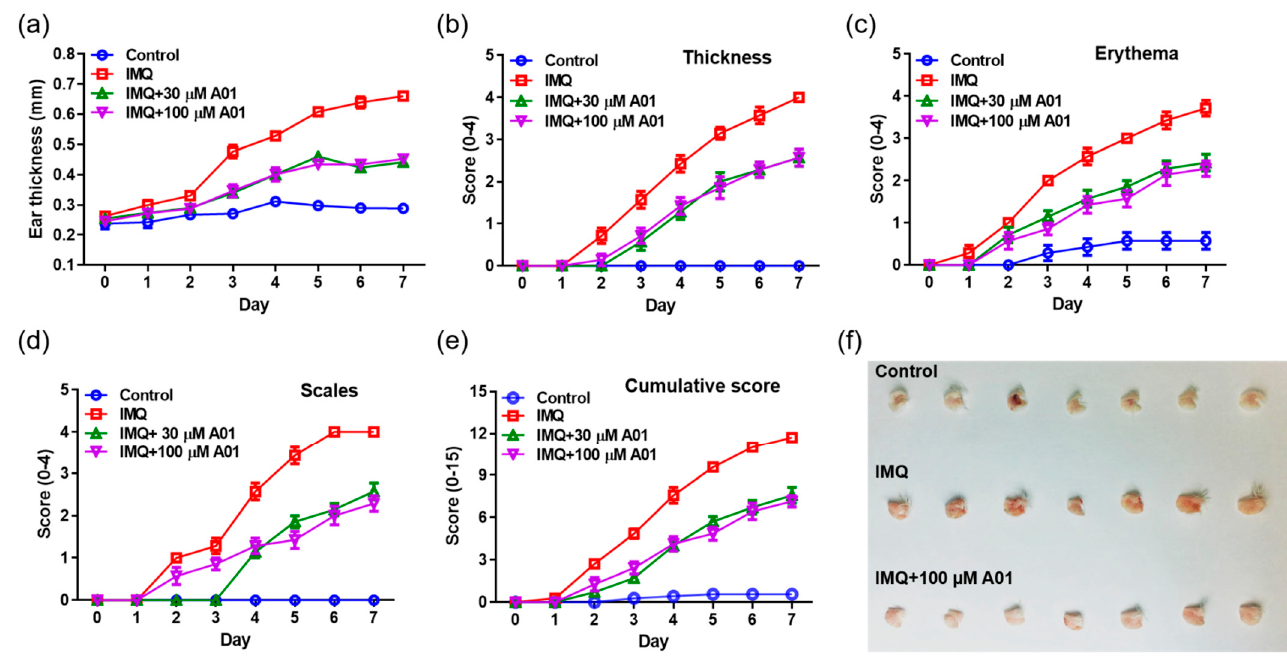
Figure 4. Alleviation of psoriasis-like symptoms in mouse ears by inhibiting ANO1. To induce psoriasis-like skin injury, three mouse groups (IMQ [ n = 7], IMQ + 30 µM A01 [ n = 7], and IMQ + 100 µM A01 [ n = 7]) received a daily dose of 25 mg of 5% IMQ cream on their right ears for 7 consecutive days; IMQ + 30 µM A01 and IMQ + 100 µM A01 groups additionally received 15 µL of 30 µM and 100 µM A01, respectively, at 30 min before and after IMQ treatment. The control group received a similar dose of Vaseline cream on their right ears. ( a ) Changes in right ear thickness caused by IMQ and A01. ( b – d ) Thickness, erythema, and scaling of right ears were scored daily. ( e ) The cumulative score (thickening plus erythema plus scaling) was described. Symbols per day depict mean ± SEM of seven mice ears per group. The significant differences among groups obtained from statistical analysis are presented in Figure S2. ( f ) Phenotypic representation of the right ears in mice treated with IMQ or IMQ + 100 µM A01 for 7 days. Imiquimod, IMQ; T16Ainh-A01, A01.